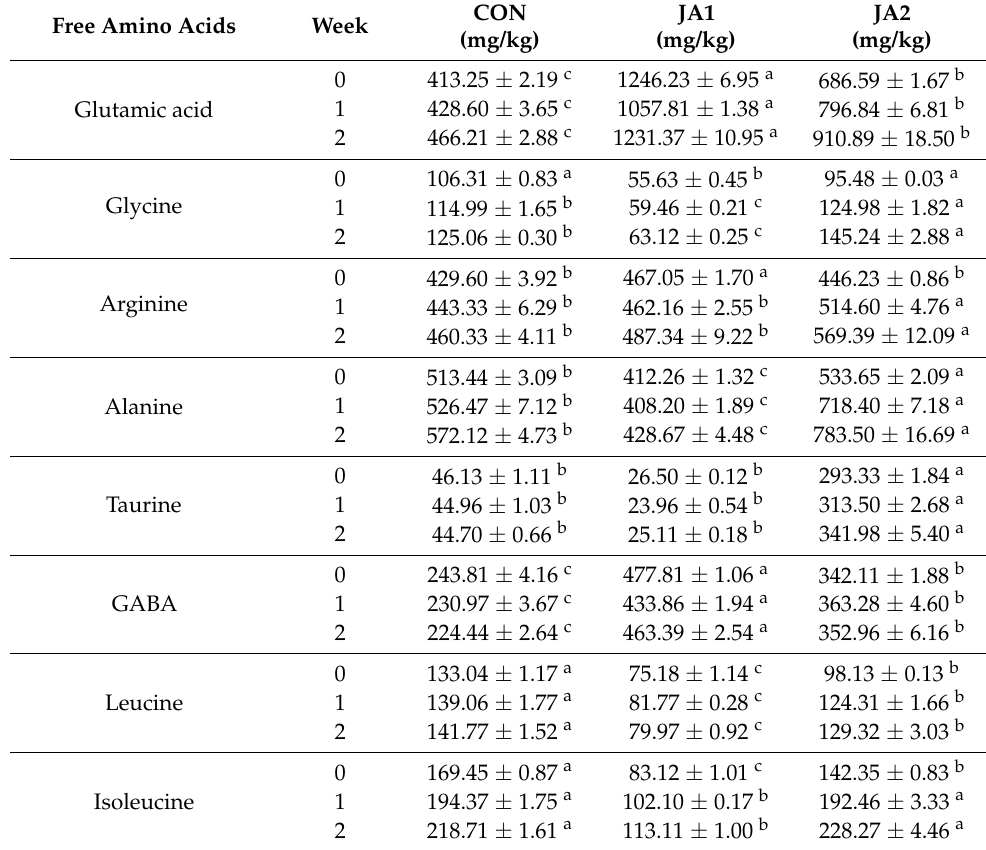
Table 8. Free amino acid composition of kimchi prepared with jeotgal alternatives. Free Amino